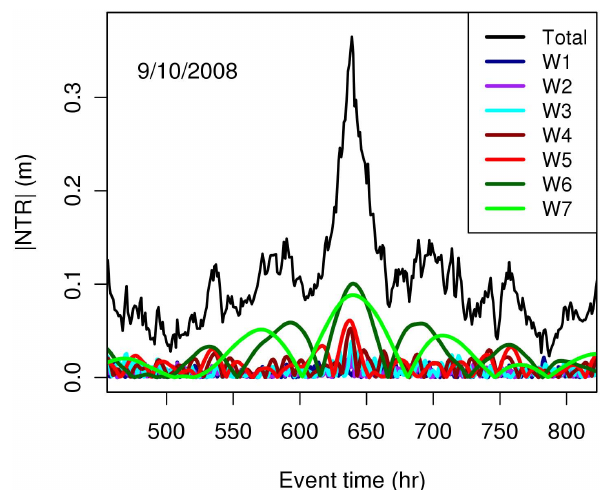
Fig. 2. Magnitude of the NTR wavelet coefficients 8 j for an event at Key West on 10 September